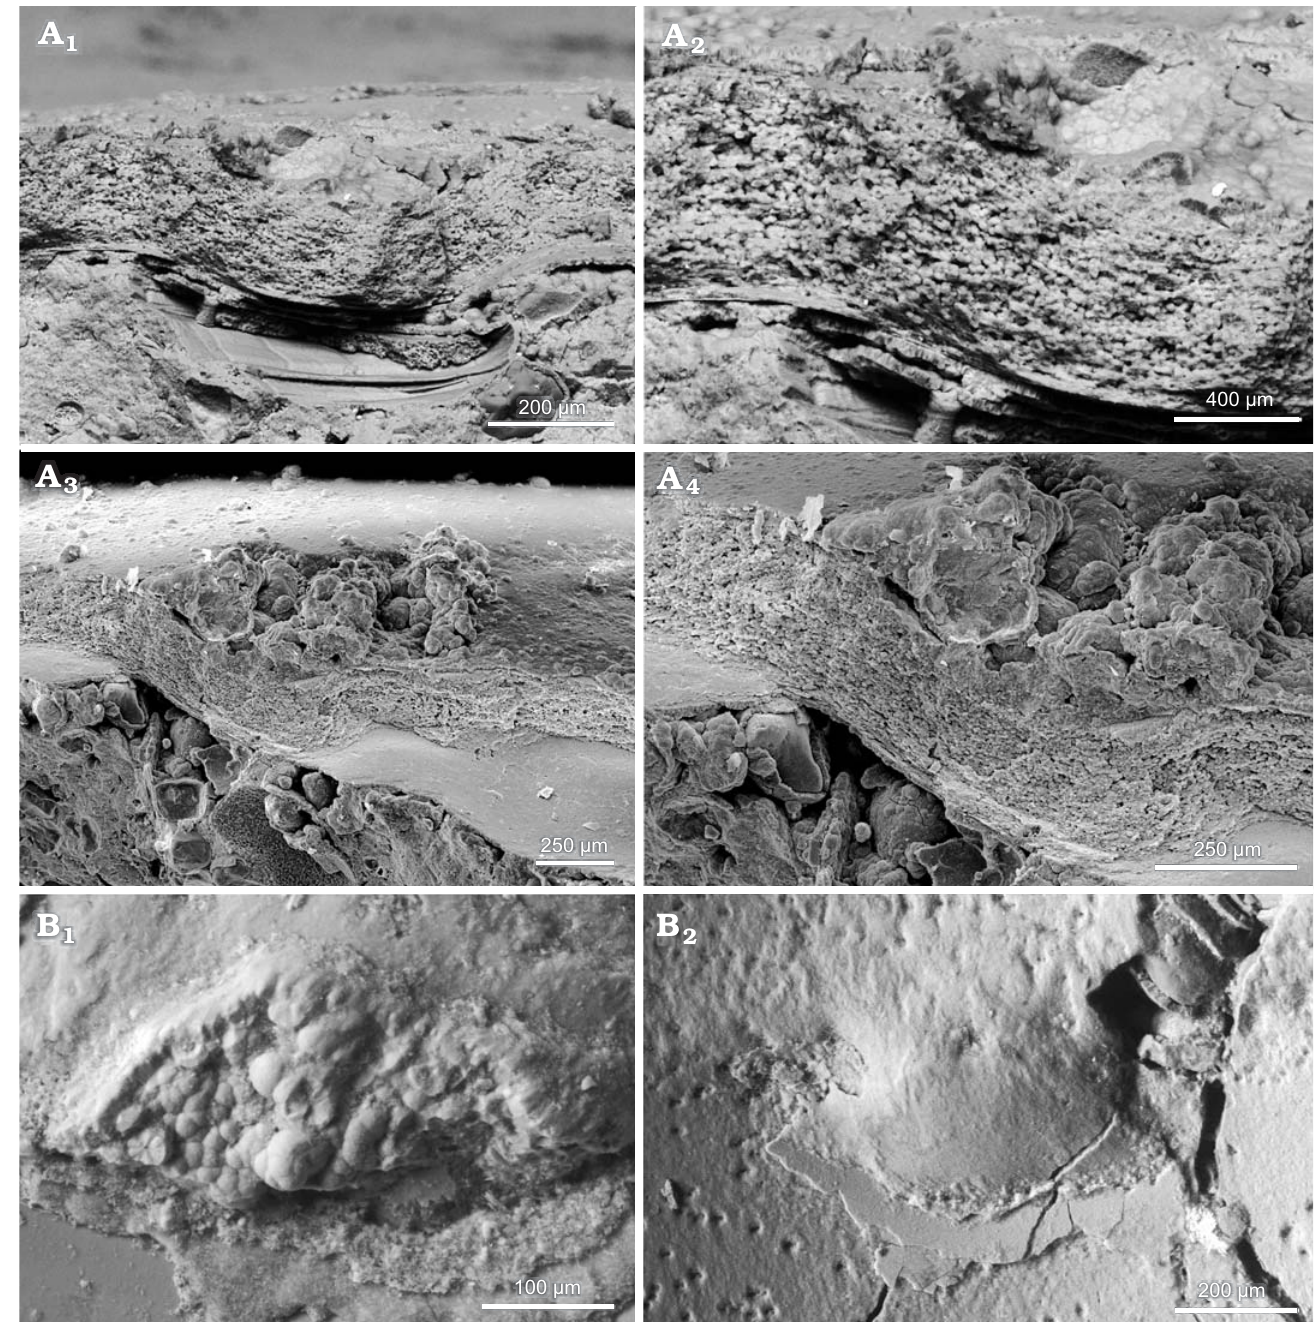
Fig. 11. SEM photographs of the pits on the craspeditid ammonite Kachpurites fulgens (Trautschold, 1861) shells from the Late Volgian, Kachpurites fulgens Zone, Eganovo (A) and Mnevniki (B) localities, Moscow region, Central Russia. A . MSU 118/1. Transverse (A 1 , A 2 ) and longitudinal (A 3 , A 4 ) cross-sections of the shell layers in the pit area. The bending of shell wall inside the pit is clearly visible. B . MSU 118/9. The phosphatic mineral inside the pit (B 1 ) and the tubercle (reflection of the pit) (B 2 ) located on the dorsal side of the